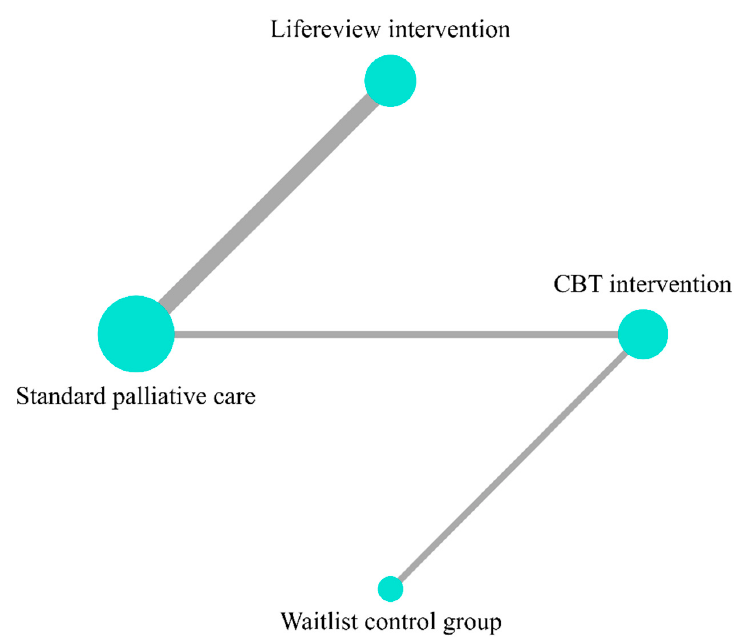
Figure 6. Network plot for outcome of Anxiety.